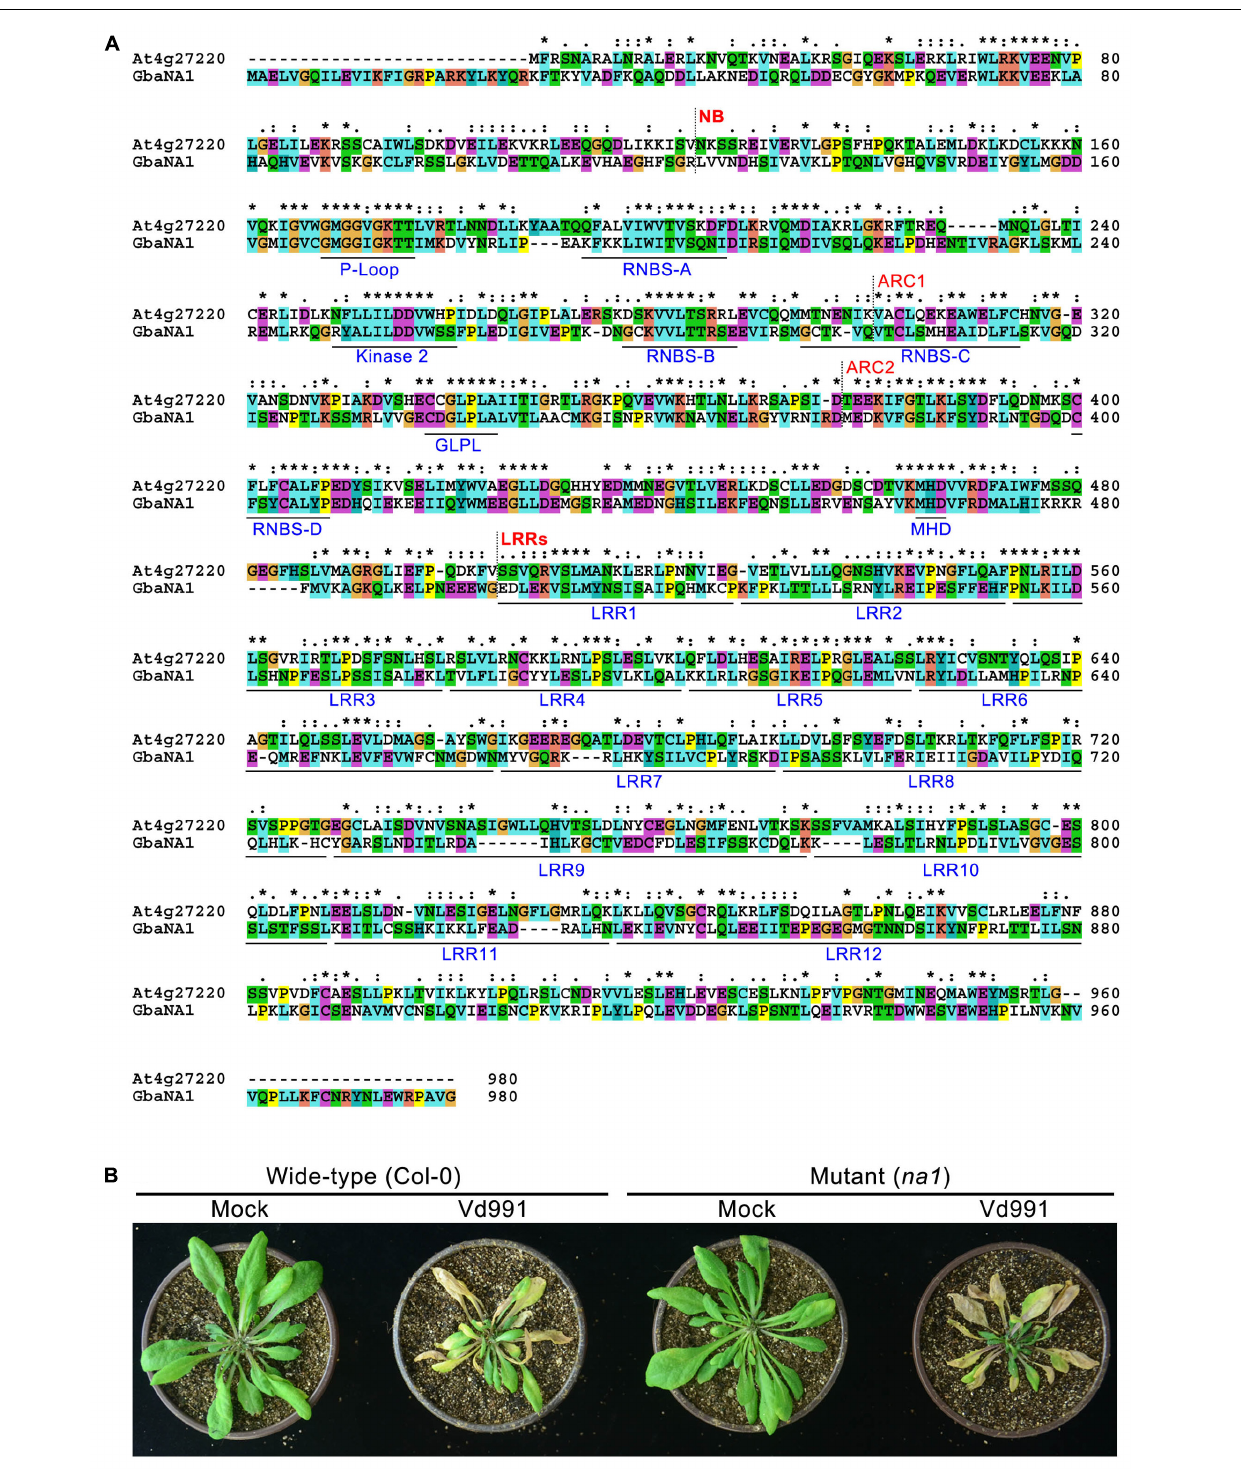
FIGURE 2 | Characteristics of GbaNA1 orthologous proteins in Arabidopsis thaliana . (A) Protein sequence alignment of GbaNA1 and its orthologous sequence in A. thaliana Col-0. The alignment was performed by Clustal X2 with a GONNET 80 protein weight matrix. Asterisks represent conserved resides. (B) Verticillium wilt phenotype A. thaliana line At4g27220 , a T-DNA mutant of the gene orthologous to GbaNA1 ( NA1 ). Two-week-old seedlings of At4g27220 (genotype na1 ) and the wild-type (Col-0) were inoculated with V. dahliae strain Vd991 by root-dipping in a suspension of 5 × 10 6 conidia/mL. Roots were dipped in sterile water as controls (Mock). Phenotypes were investigated 14 days after